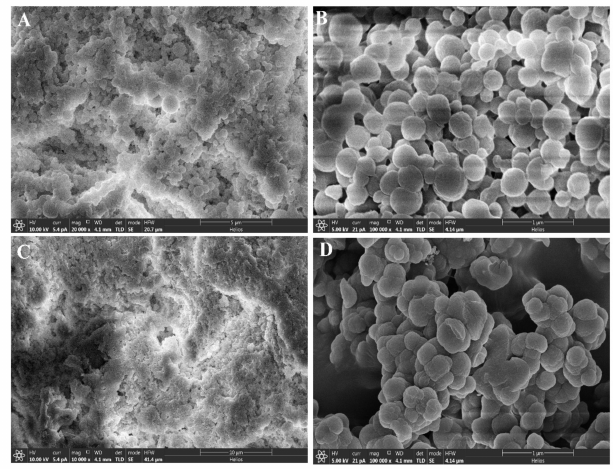
Figure 2. SEM images of ( A ) N1, ( B ) M1, ( C ) N10, ( D )